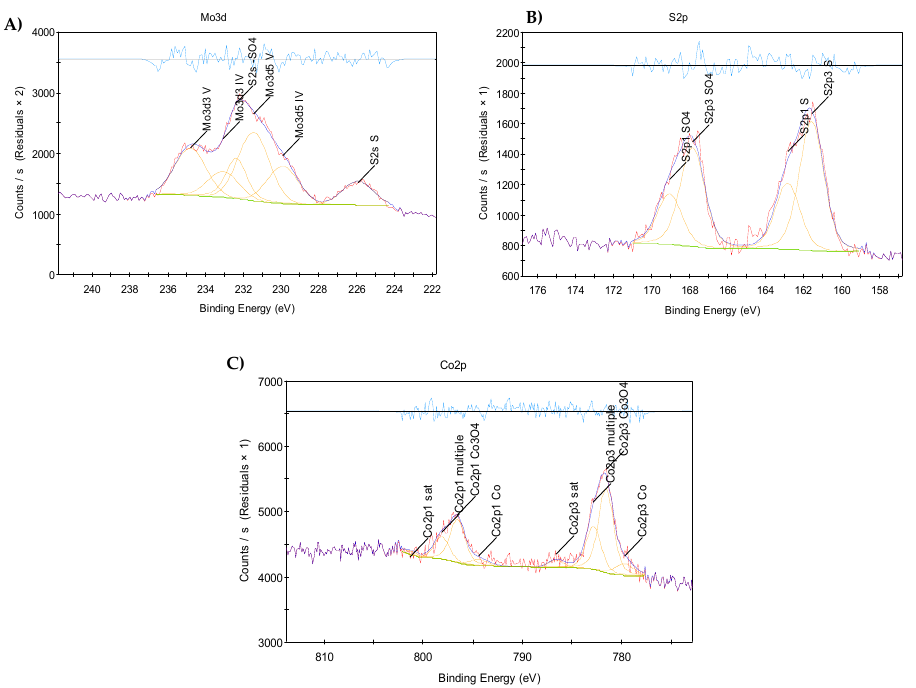
Figure 4. X-ray photoelectron spectroscopy (XPS) analysis of fresh Co / MoS 2 catalyst. ( A ) Binding energy corresponding to Molybdenum 3 d 3 / 2 , ( B ) Binding energy corresponds to Sulfur 2 p 3 / 2 and ( C ) Binding energy corresponds to Cobalt 2 p 3 / 2 all corresponds to Co-Mo-S phase as present on the spherically shaped Co / MoS 2 nanoparticles was discussed previously by Ramos et al. [16].